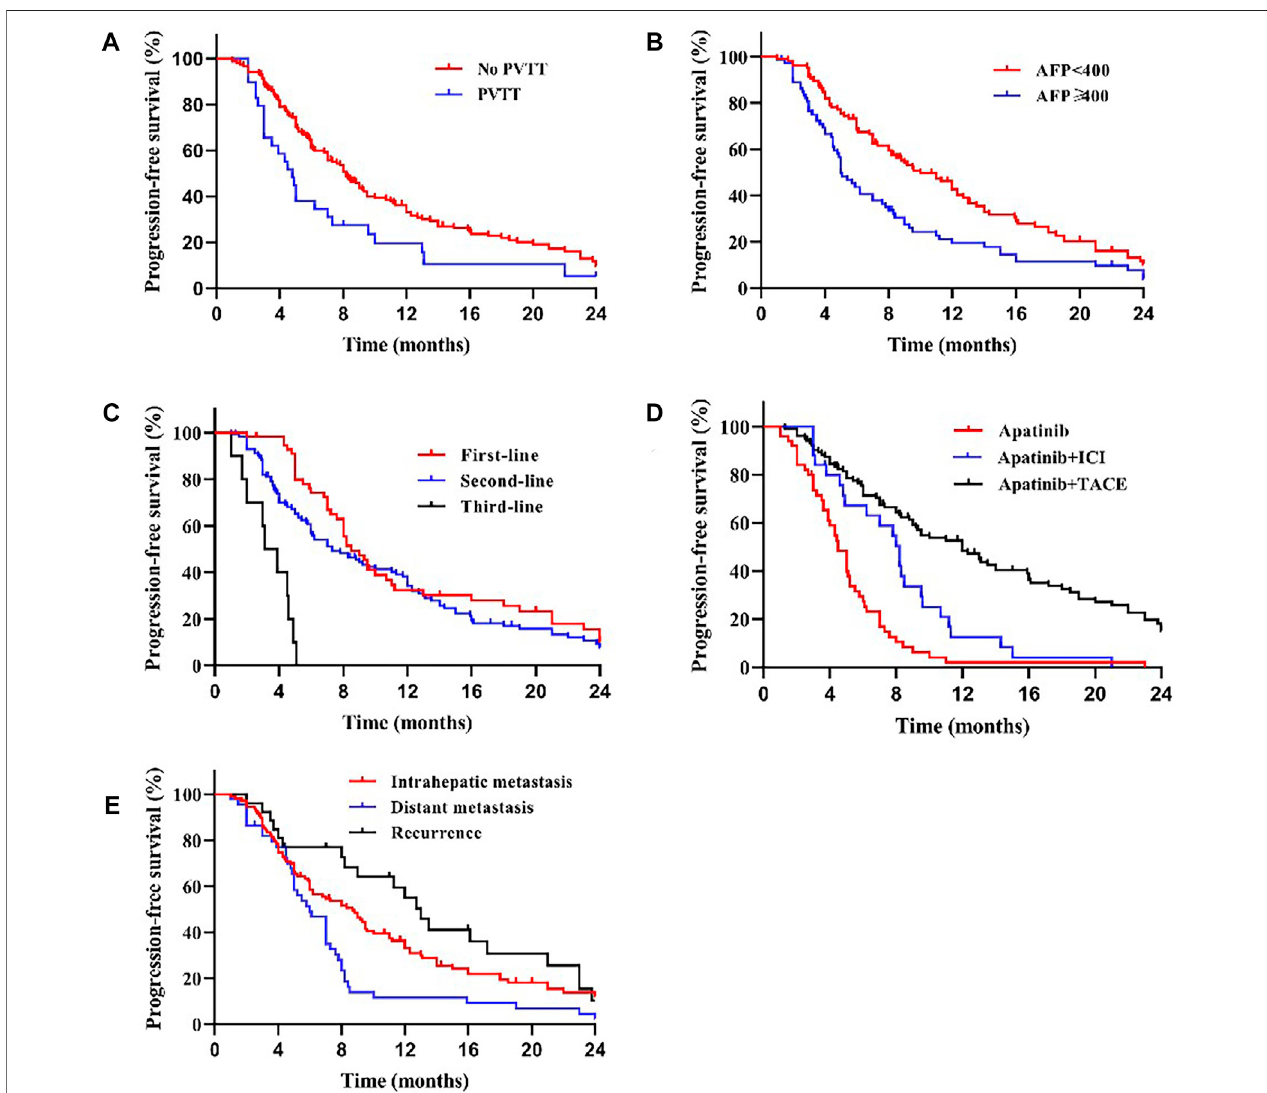
FIGURE 2 | Kaplan – Meier curves showing the PFS of patients by univariate analysis with advanced HCC treated with apatinib, including signi fi cantly different results. (A) Comparison of PFS between patients with PVTT (present) and without PVTT (absent) before the apatinib therapy. The mPFS was 4.8 months (95% CI: 3.75 – 5.86) for treatment with PVTT versus 8.0 months (95% CI: 7.06 – 8.94) for treatment without PVTT ( p < 0.05). (B) Comparison of PFS between patients with AFP < 400 ng/ml and AFP ≥ 400 ng/ml before the apatinib therapy. The mPFS was 8.7 months (95% CI: 6.95 – 10.46) for patients with AFP < 400 ng/ml versus 5.0 months (95% CI: 4.44 – 5.56) for patients with AFP ≥ 400 ng/ml ( p < 0.05). (C) The mPFS was signi fi cantly longer in fi rst-line (8.2 months, 95% CI: 7.39 – 9.01) and second-line (7.0 months, 95% CI: 5.27 – 8.73) treatment patients than in third-line (3.1 months, 95% CI: 1.71 – 4.50) treatment ( p < 0.001). (D) The mPFS of apatinib combined with TACE (11.0 months, 95% CI: 8.32 – 13.68) and immunotherapy (8.0 months, 95% CI: 6.53 – 9.47) was longer than that of apatinib monotherapy (4.4 months, 95% CI: 3.63 – 5.17) ( p < 0.001). (E) The mPFS was shorter in patients with distant (5.8 months, 95% CI: 4.50 – 7.10) and intrahepatic